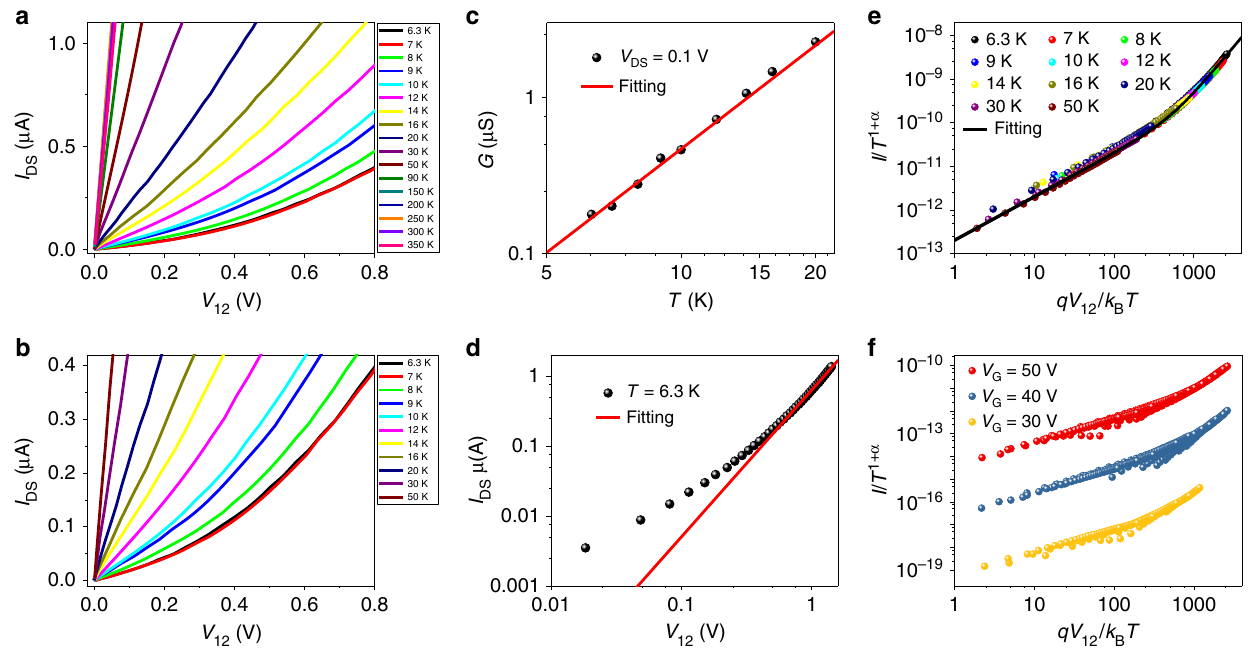
Fig. 5 Evidence of Luttinger liquid transport in monolayer MoS 2 FET. a Typical ( I DS – V 12 ) curves measured under V G = 60 V, varying temperature from 350 to 6.3 K. b The ( I DS – V 12 ) below 50 K are shown, illustrating clear nonlinear charge transport behavior in monolayer MoS 2 FET. c Power law relation of conductance G with temperature ( G ∼ T α ) at low bias V 12 = 0.1 V, obtaining a fi tting exponent α = 2.2 from the red fi tting curve. d Power law relation of the (cid:2) V β current with the voltage I at low temperature T = 6.3 K, having a fi tting exponent β = 2.2. e The output transport data and the corresponding curve DS 12 plotted by I DS / T 1 + α against qV 12 / k B T under the gate voltage of V G = 60 V. The nonlinear ( I DS – V 12 ) data scale well onto a universal curve over the temperature range from 50 to 6.3 K. The fi tting curve indicates nonlinear Luttinger liquid behavior. f ( I DS – V 12 ) data scale onto the universal curve replotted as I DS /T 1 + α versus qV 12 / k B T under other gate biases: V G = 30, 40, and 50 V,